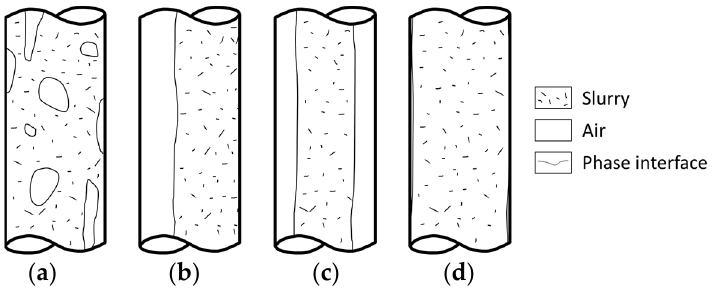
Figure 9. Main flow patterns of paste slurry flowing in vertical pipes. ( a ) Mixed flow; ( b ) stratified flow; ( c ) columnar flow; and ( d ) full-pipe flow.